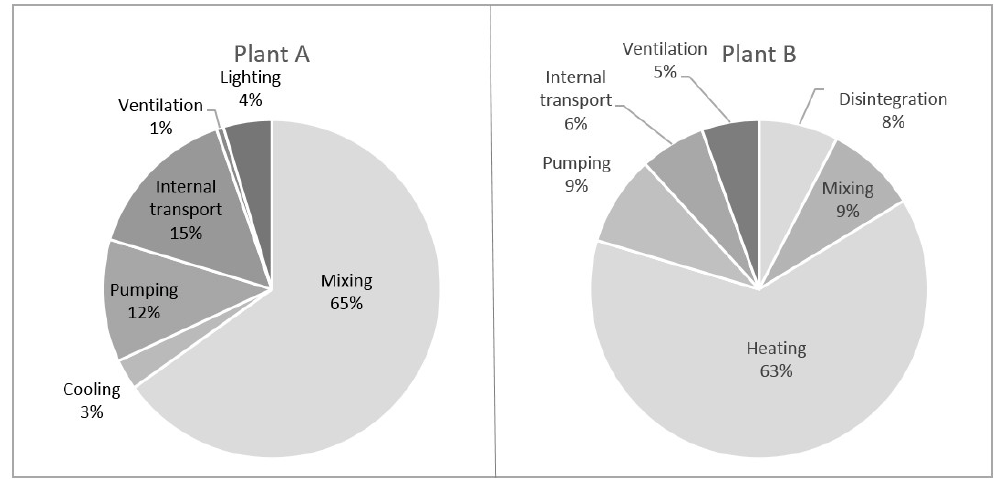
Figure 12 . The total energy use at system Level 1, allocated to unit processes for plant A and B, respectively. For plant A, the only energy carrier used during the measurement period was electricity.